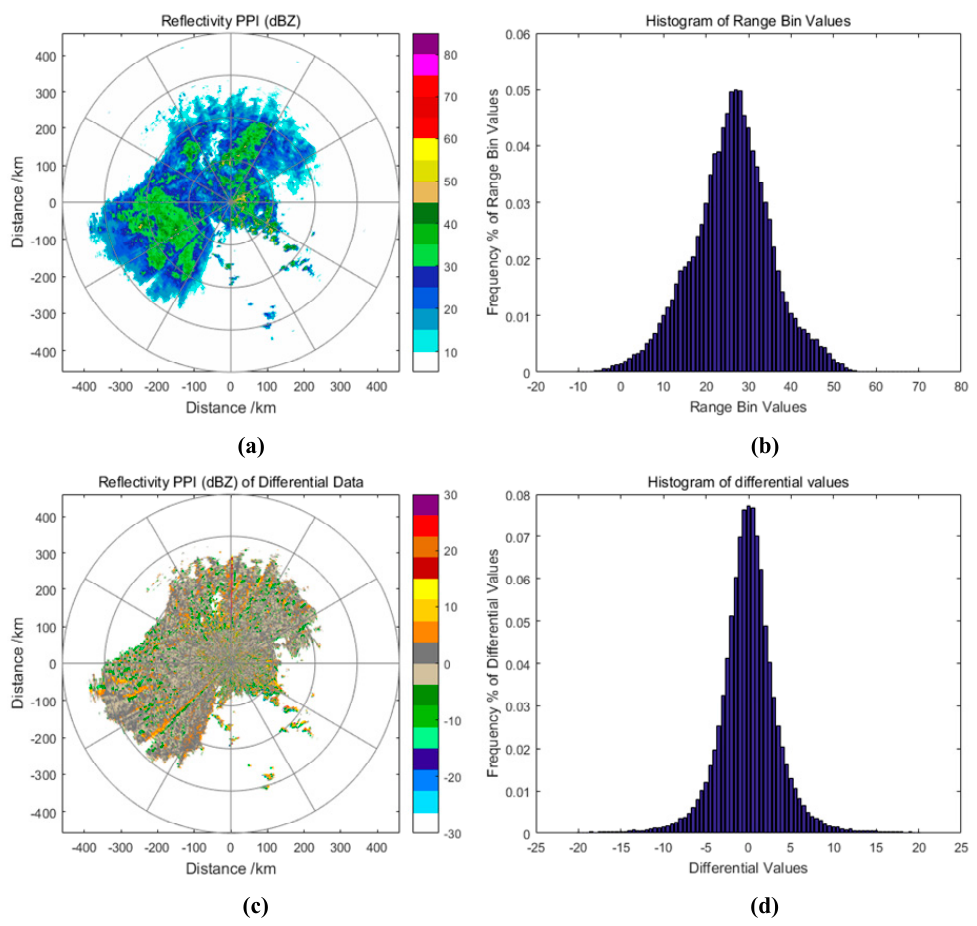
Figure 3. The distribution of raw data and differential data. The differential data is calculated by difference between the current radial and its previous radial. ( a ) Reflectivity PPI (dBZ) of CINRAD SA data; ( b ) frequency histogram of range bin values in raw data; ( c ) reflectivity PPI (dBZ) of differential CINRAD SA data; and, ( d ) frequency histogram of differential range bins values that are calculated from Equation (1).